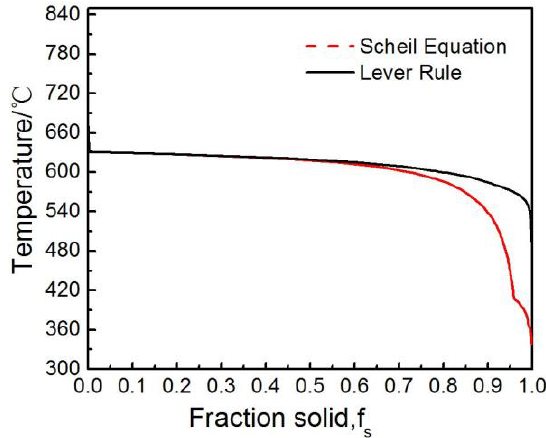
Figure 2. Temperature vs solid fraction curves of the AZ31 alloy, obtained by thermodynamic simulation with the lever rule and the Scheil equation.